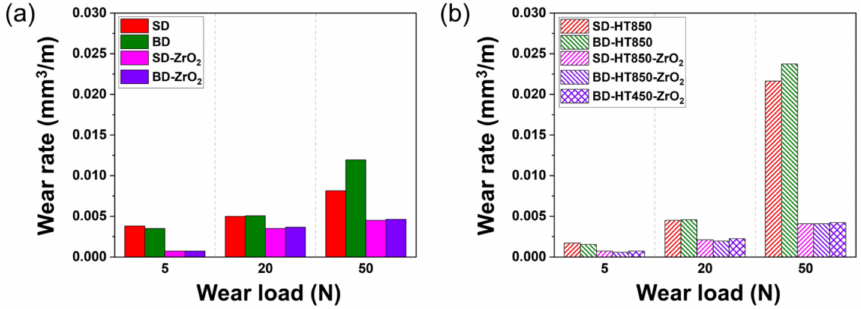
Figure 9. Comparison of the wear rates after the wear tests using AISI 52100 steel and ZrO 2 balls as counterpart materials. ( a ) As-built and ( b ) heat-treated